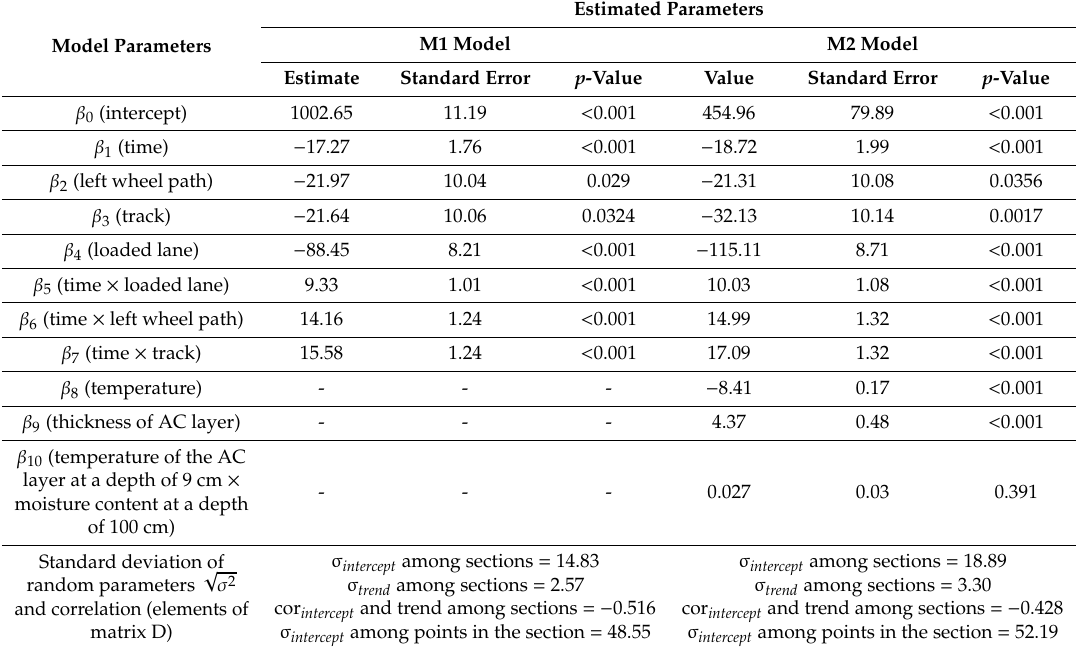
Table 5. Estimated parameters of models M1 and M2.